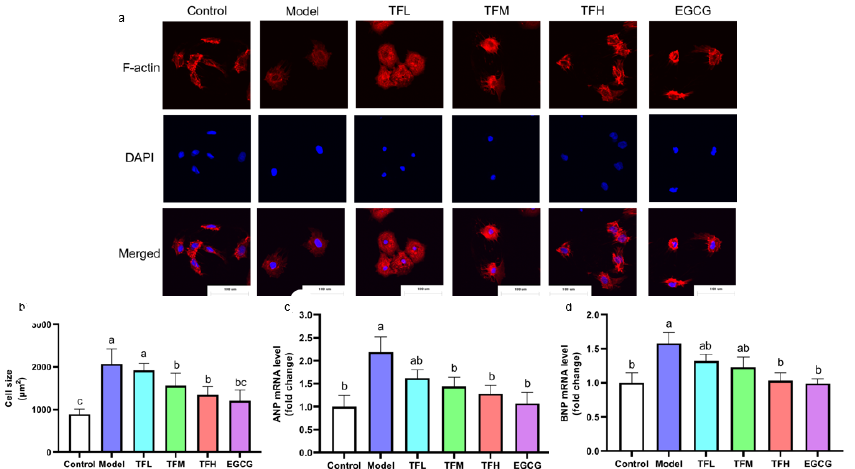
Figure 3. ( a ) Morphology change of H9c2 cells treated with different concentrations of TF3 and EGCG ( × 400). ( b ) Size of H9c2 cells treated with TF3 and EGCG. ( c ) ANP mRNA level of H9c2 cells treated with TF3 and EGCG. ( d ) BNP mRNA level of H9c2 cells treated with TF3 and EGCG. Control group, no ANGII treatment; Model group, ANGII 0.5 µ M induction; TFL group, TF3 1 µ M pretreatment and ANGII 0.5 µ M induction; TFM group, TF3 5 µ M pretreatment and ANGII 0.5 µ M induction; TFH group, TF3 10 µ M pretreatment and ANGII 0.5 µ M induction; EGCG group, EGCG 50 µ M pretreatment and ANGII 0.5 µ M induction. Significant differences between different treatments were shown by different letters ( p < 0.05) .